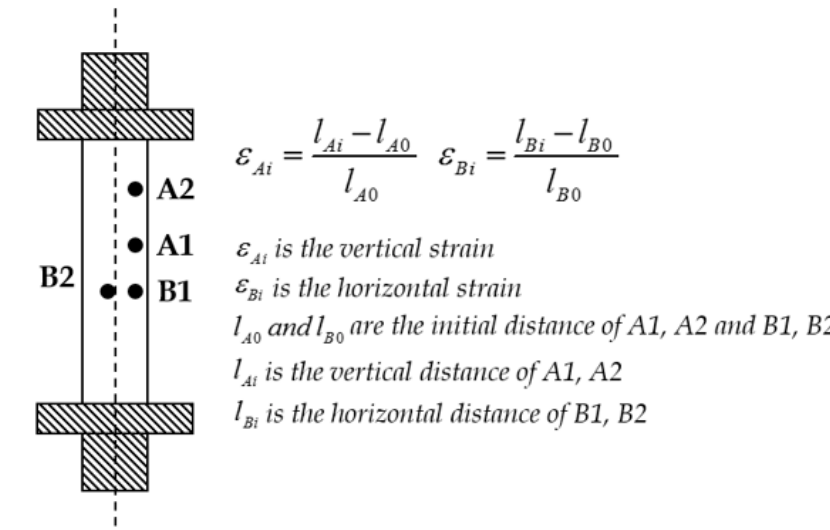
Figure 3. Schematic of vertical and horizontal strain calculations using DIC for a tension test.